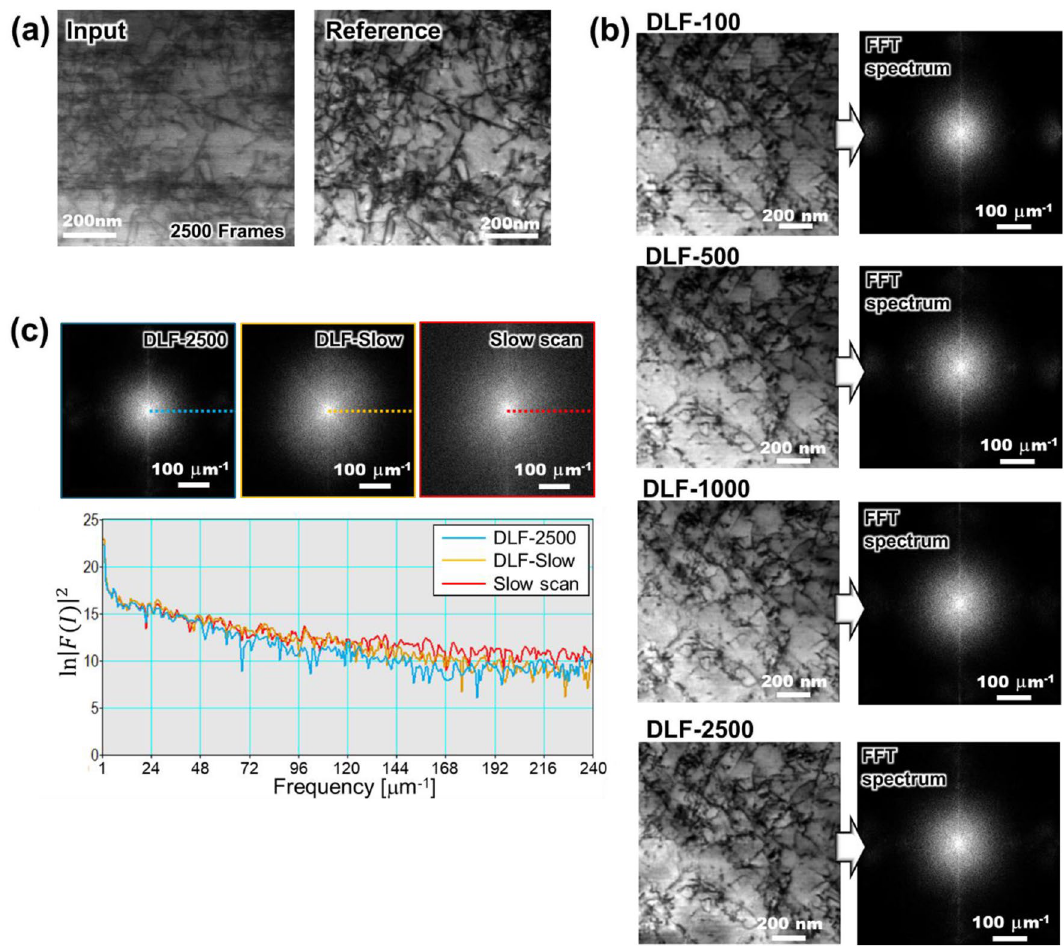
Figure 6. Single FOV training procedure and its results. We performed additional observation and obtained ( a ) 2500 frames of rapid scan images and a slow scan image (reference image) from single view. The data set shown in ( a ) has already processed by the distortion correction. The results of single FOV trained DL filters are shown in ( b ), where DLF-xxx means xxx [frames] of ( a ) were used during the training. ( c ) The line profiles of FFT spectrum are evaluated in the same way as Fig.